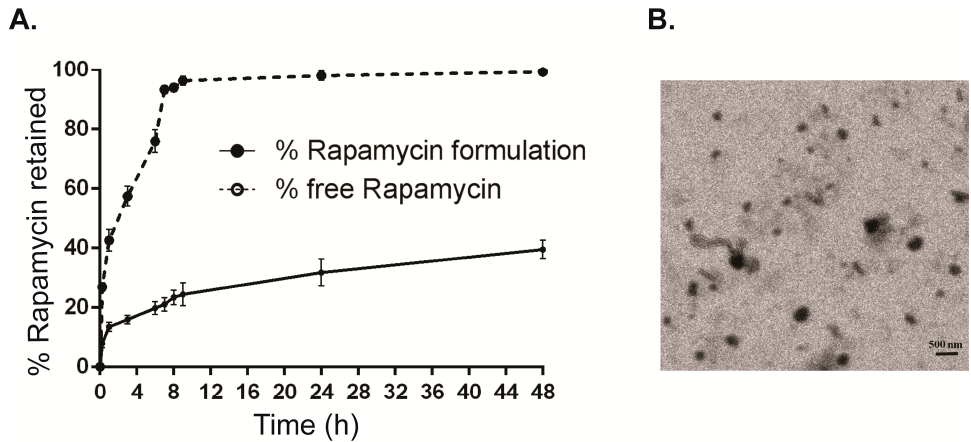
Figure 1. ( A ) Release study of rapamycin formulation for 48 h. ( B ) Transmission electron microscopy image of encapsulated Rapamycin (Black dots).